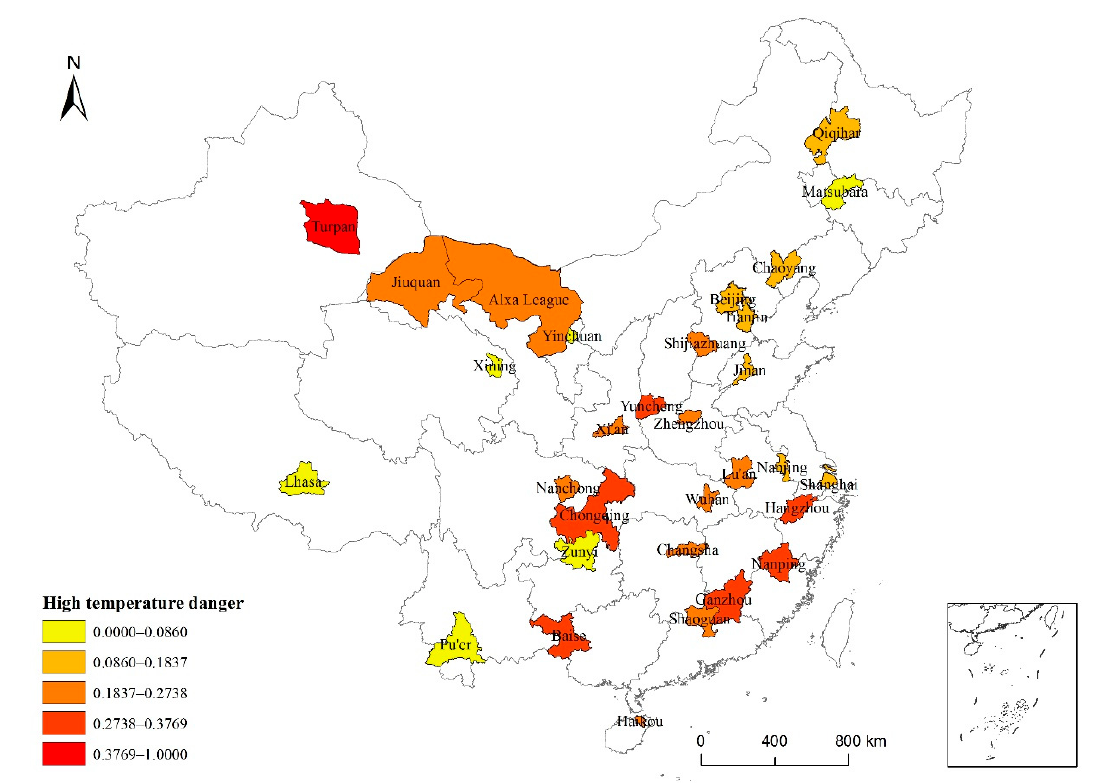
Figure 5. High-temperature risk levels for 31 typical cities across China based on data from 1986 to 2015.